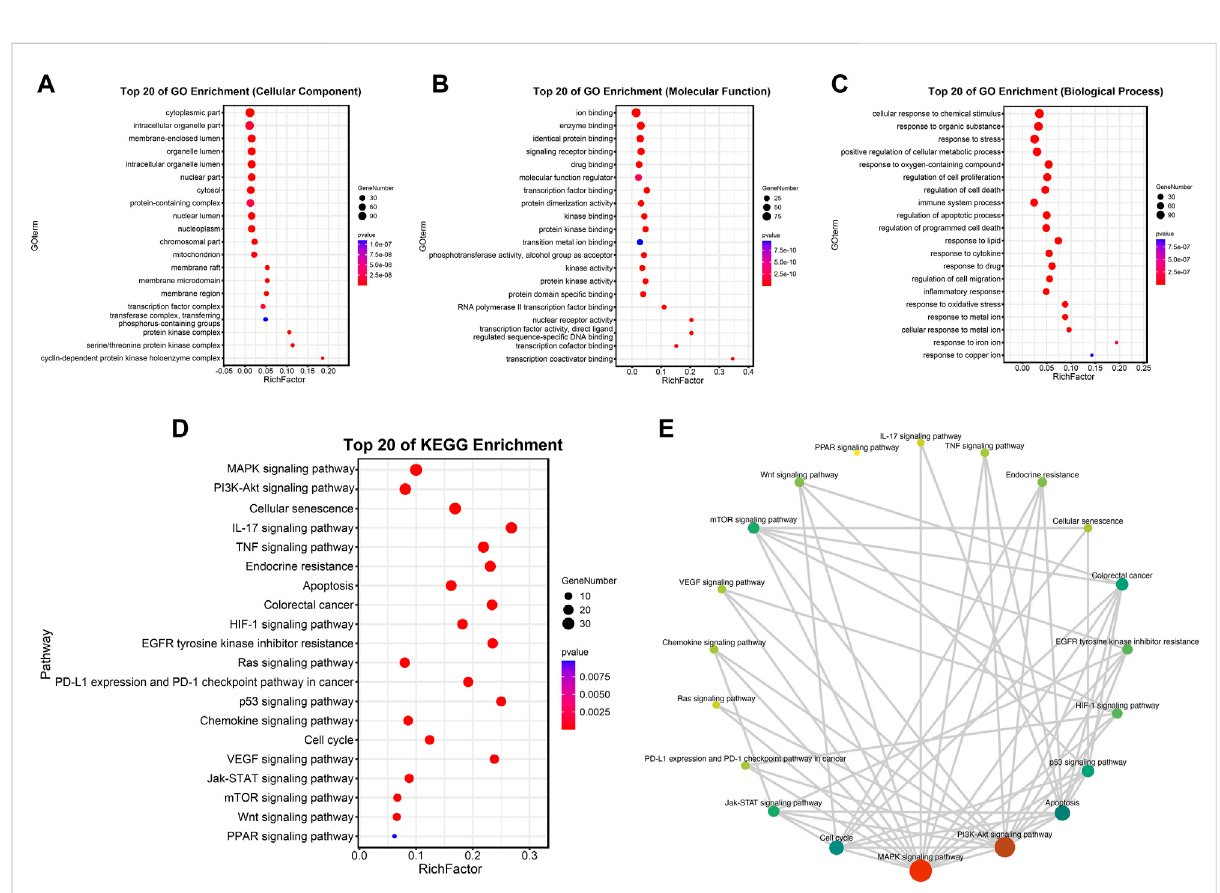
FIGURE 5 Analysis of functional enrichment. (A – C) Top 20 cellular components (A) , top 20 molecular functions (B) and top 20 biological processes (C) in the GO enrichment analysis. (D,E) Top 20 pathways in the KEGG enrichment